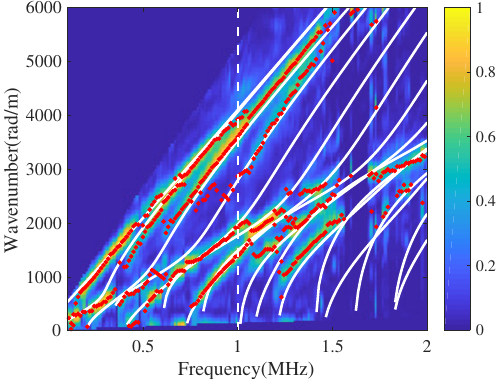
Figure 6. Wavenumbers of the 4-mm-thick bone-mimicking plate estimated using the conventional SVD method. The color intensity map shows the results obtained using the conventional SVD method. Solid white lines show the theoretical curves.